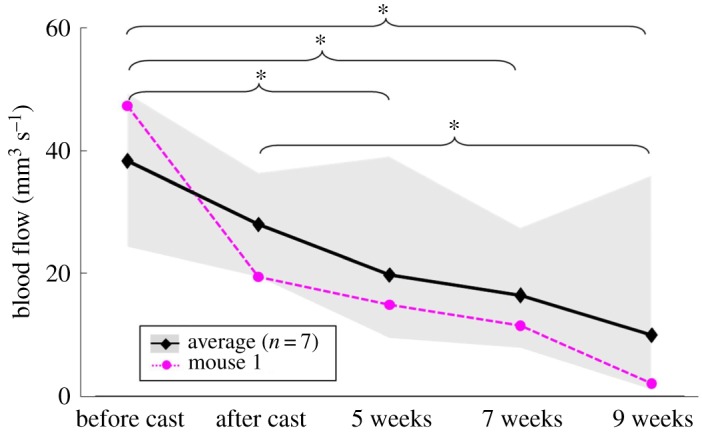
Blood flow along RCCA over time: average of seven animals showed a general decrease in blood flow over time (black line, * indicates p < 0.05, repeated-measures ANOVA); mouse 1 (pink line); shadow area indicates data range of all animals.